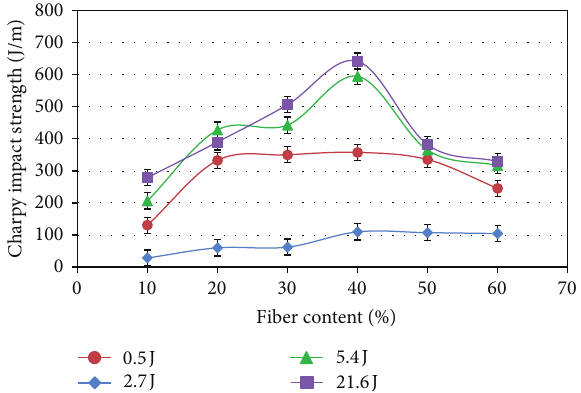
Figure 9: Effect of fiber content on impact strength of kenaf/PVB composites.